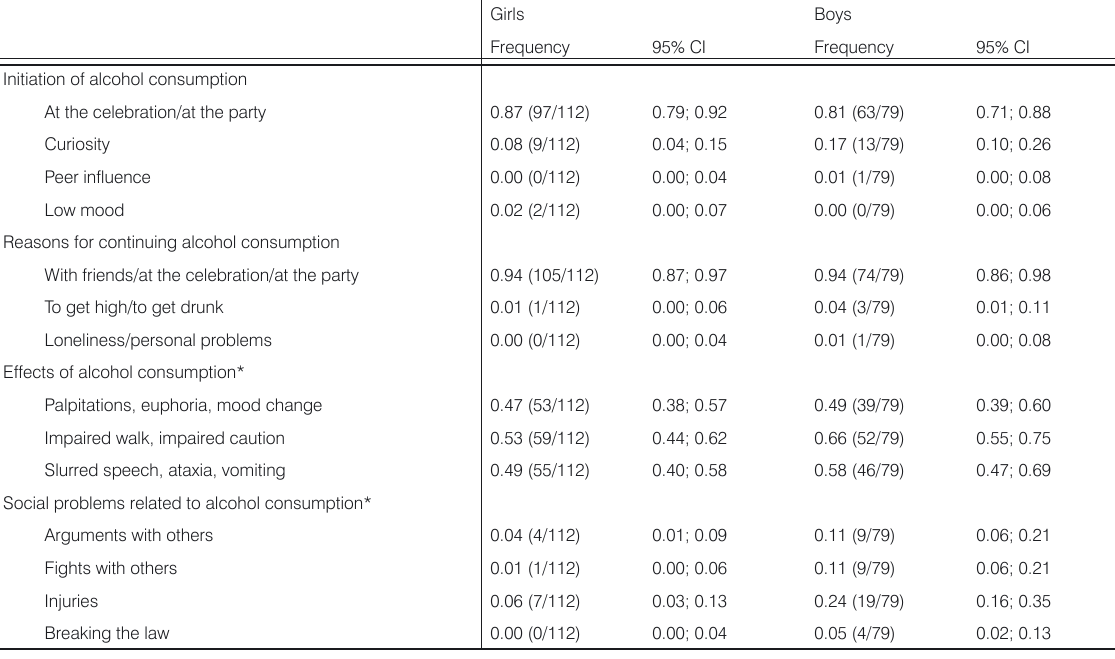
Table 1. The frequency distribution of the current alcohol consumption intensity and frequency, experienced symptoms and problems related to alcohol consumption among adolescents, stratified according to the